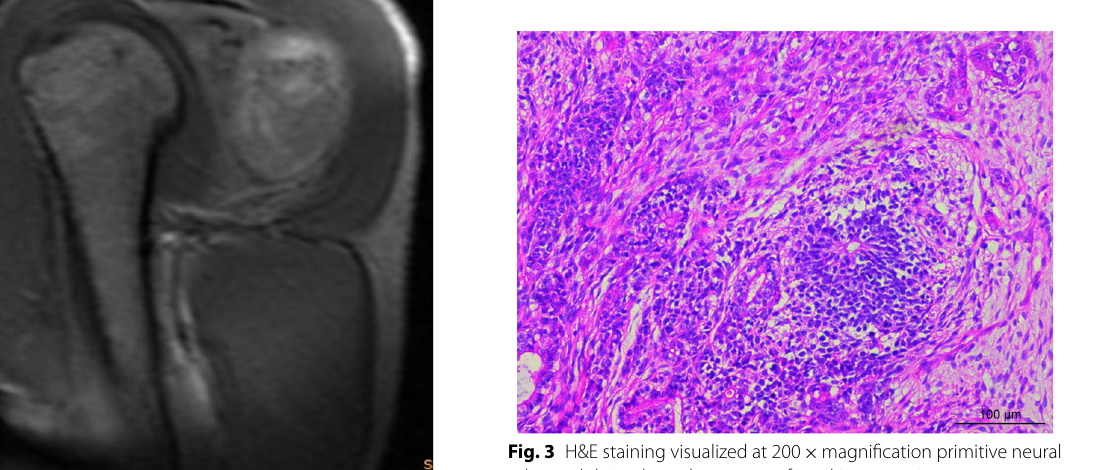
magnification primitive neural ×